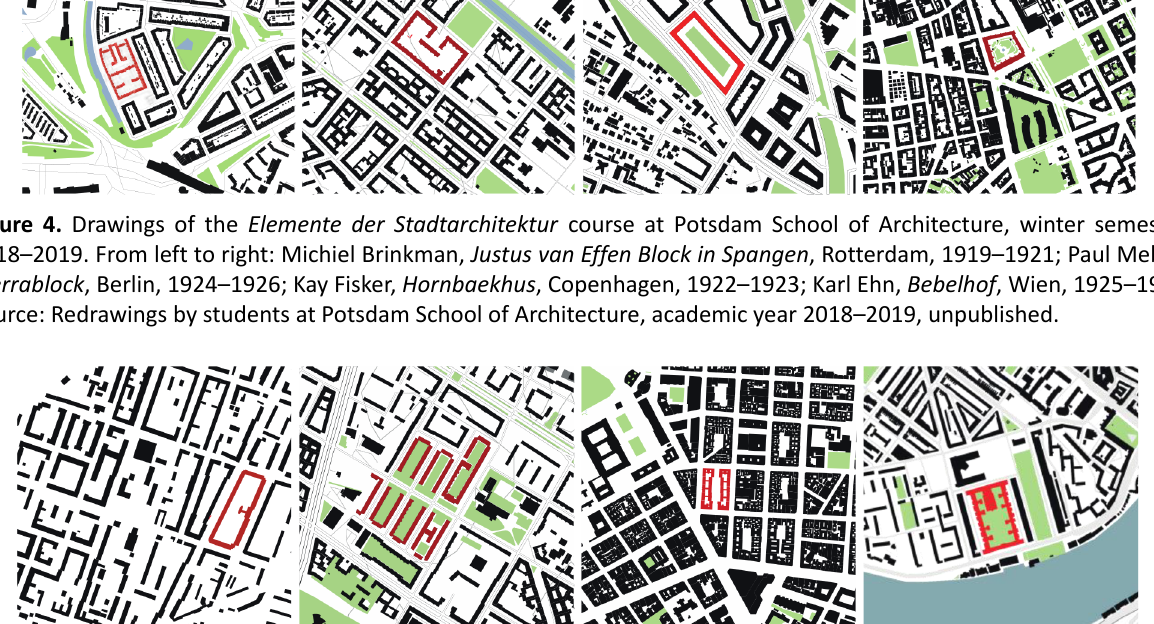
Berlin, strongly criticized since its approval in 1862 and then drastically planned in the 1920s (Arminius, 1874;